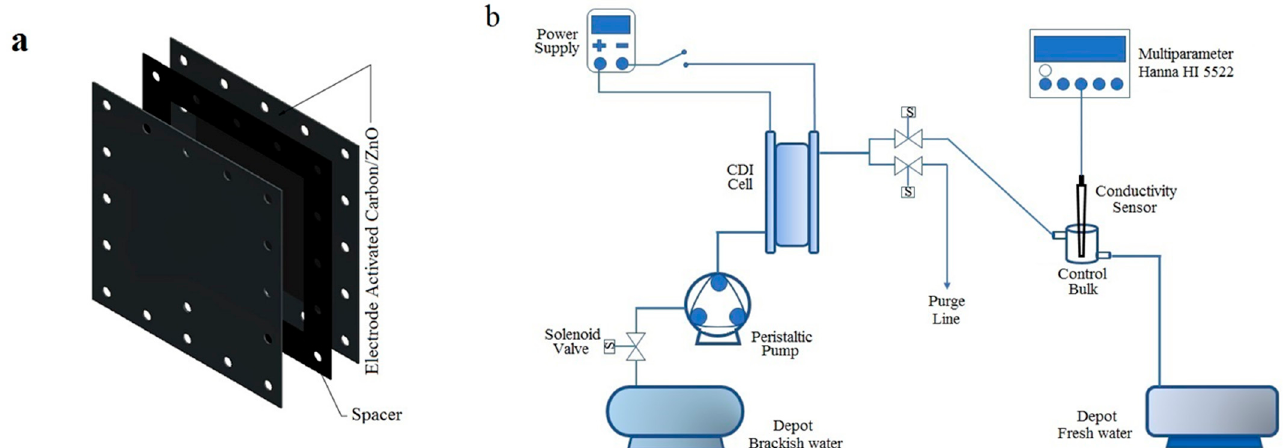
Figure 9. ( a ) Schematic of one of the nine pairs of electrodes of a CDI cell and ( b ) schematic of the main experimental setup used for the CDI studies. In this diagram, different elements such as CDI cell, peristaltic pump, DC power supply, conductivity sensor, and pH meter are